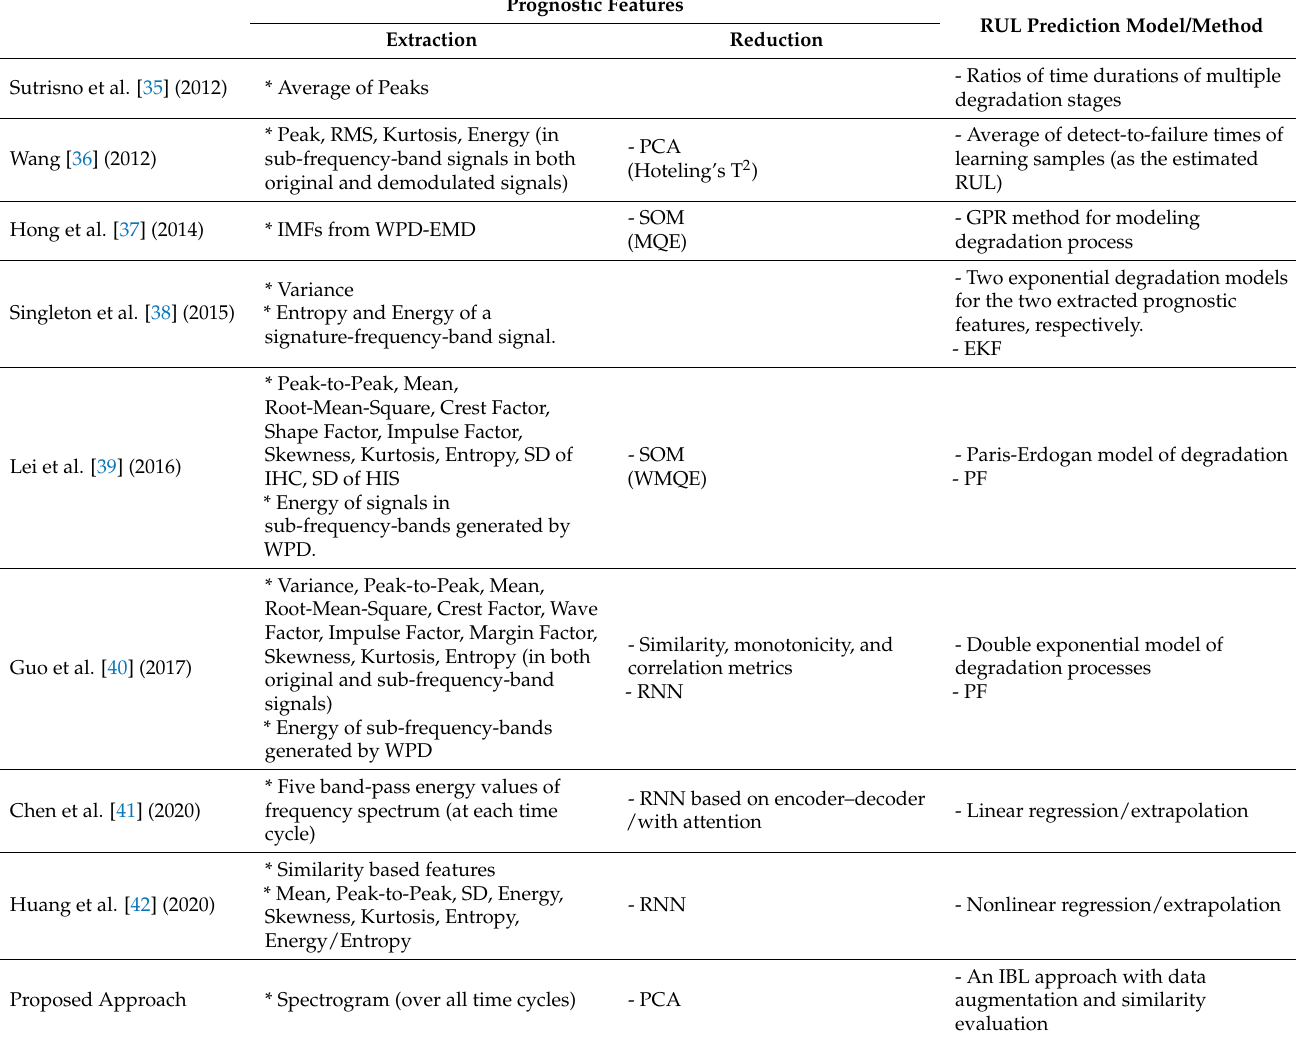
Table 8. Summary of the existing